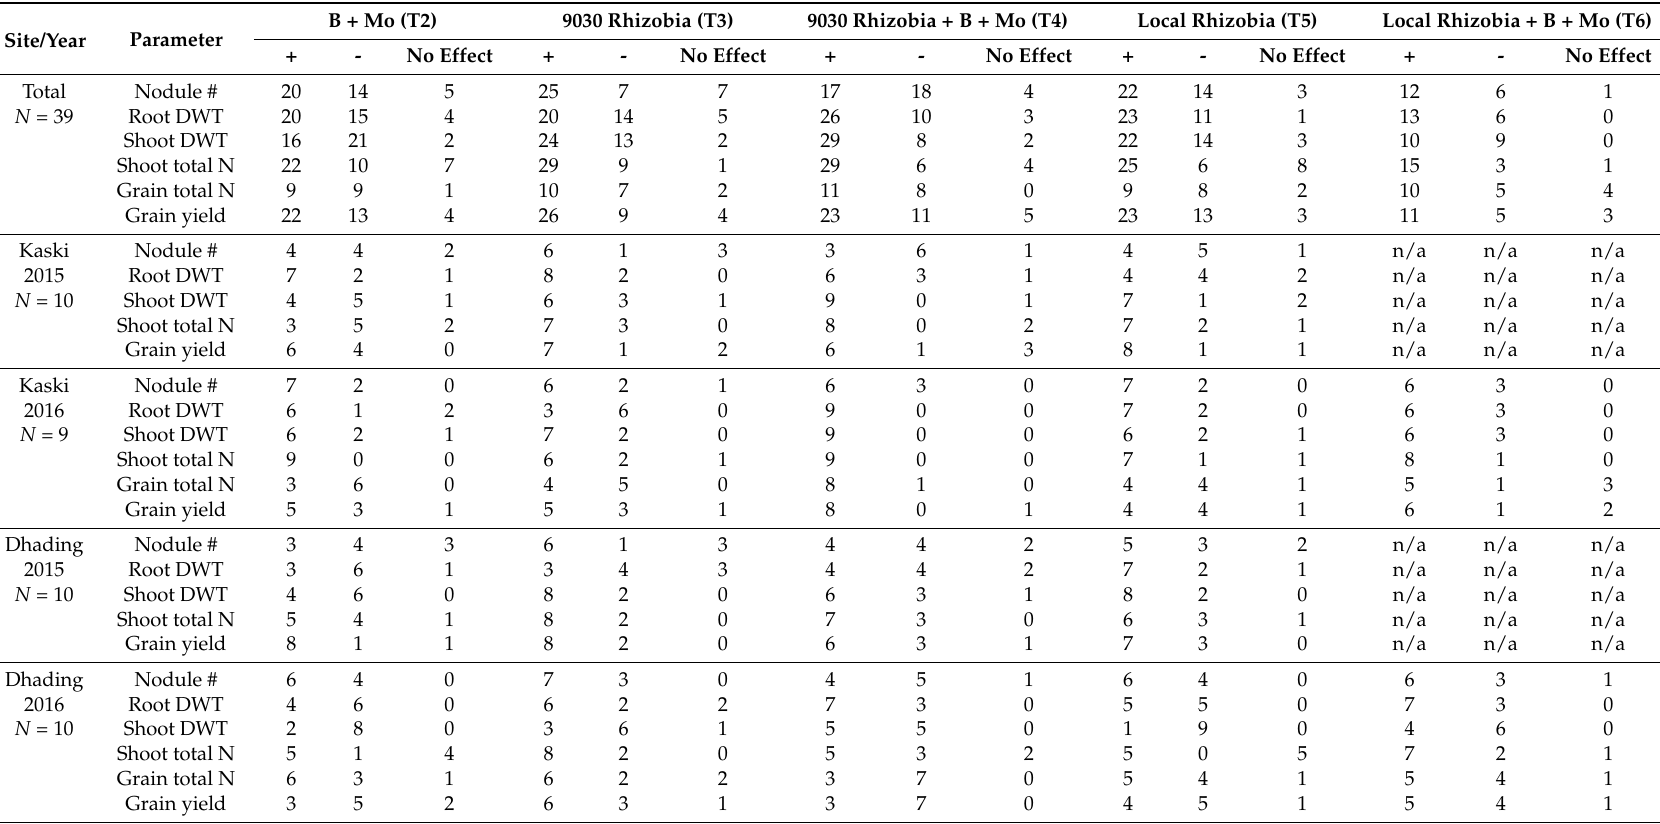
Table 1. The number of farms that benefitted (+, >5%), were negatively affected (-, < − 5%), or experienced no effect ( − 5% ≤ 5%), from the rhizobium/micronutrient treatments compared to internal control plots (T1, uninoculated and without micronutrients) for the agronomic parameters tested at the Dhading and Kaski sites in 2015 and